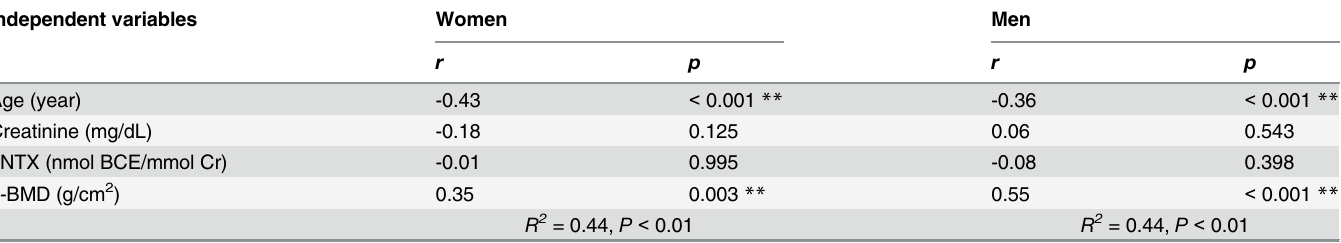
Table 3. Multiple regression analysis of the clinical parameters that affect the vertebral strength index. Independent